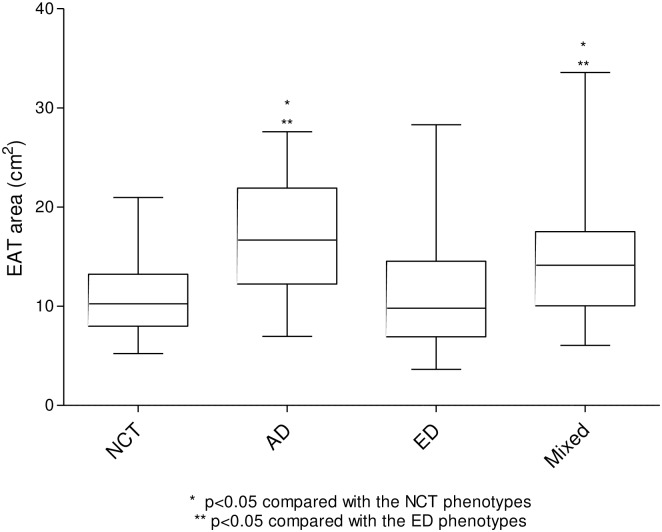
Association of EAT area with the CT phenotypes in COPD patients.The Wilcoxon Rank-Sum test was used to compare groups. The subjects with the AD and Mixed phenotypes had greater EAT areas than those with the NCT and ED phenotypes.